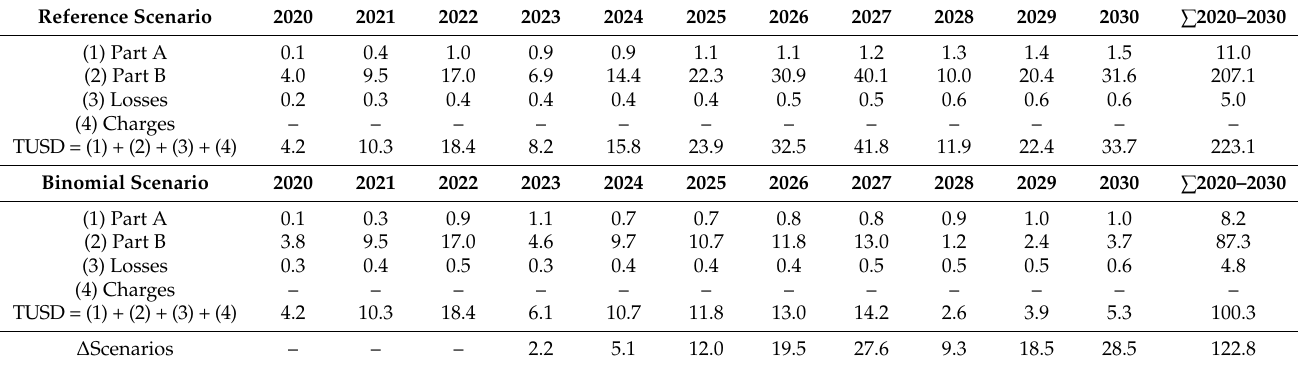
Table 14. Irrecoverable portion of MMDG for Enel Cear á , in million USD.